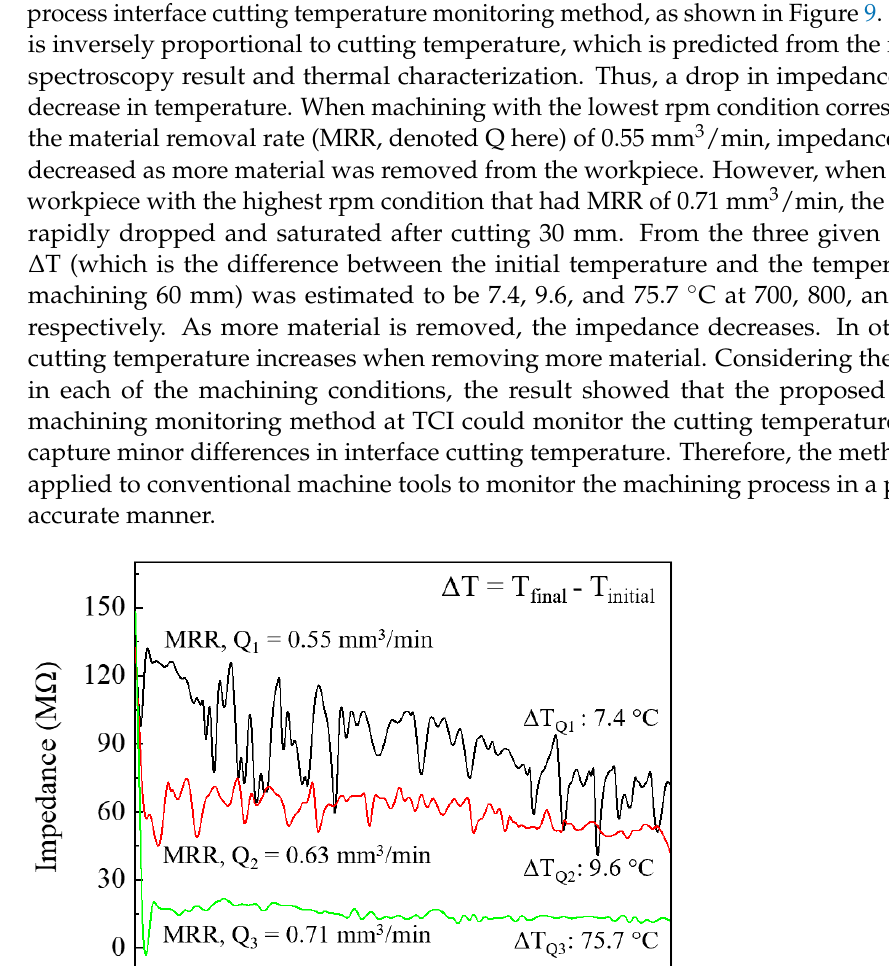
Figure 8. Microscope image of machined surface: ( a ) 700 rpm, ( b ) 800 rpm, and ( c ) 900 rpm.